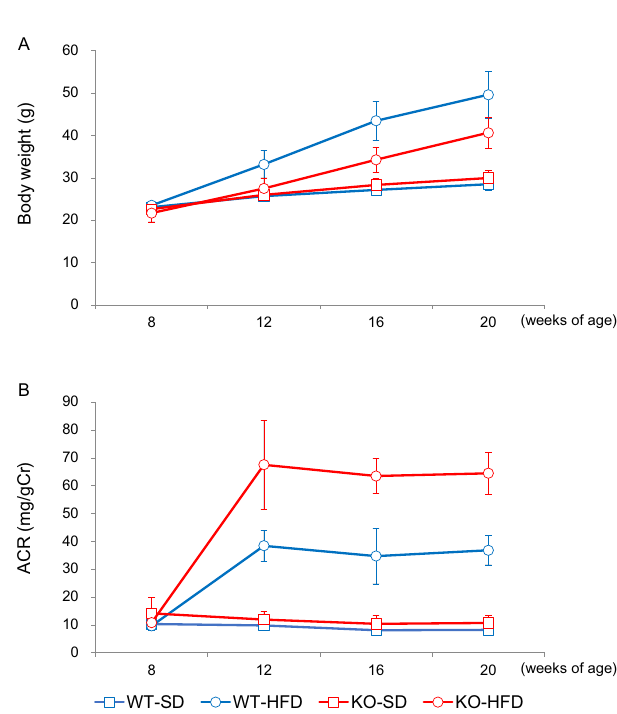
Figure 1. Mean body weight and urinary ACR in each experimental group. ( A ) Body weight was measured at 8, 12, 16, and 20 weeks of age. The KO-HFD group was protected against obesity despite the lack of difference in food intake between the KO-HFD and WT-HFD groups. ( B ) Urinary ACR, measured at 12, 16, and 20 weeks of age, is highest in the KO-HFD group at all timepoints. Data are expressed as means ± standard